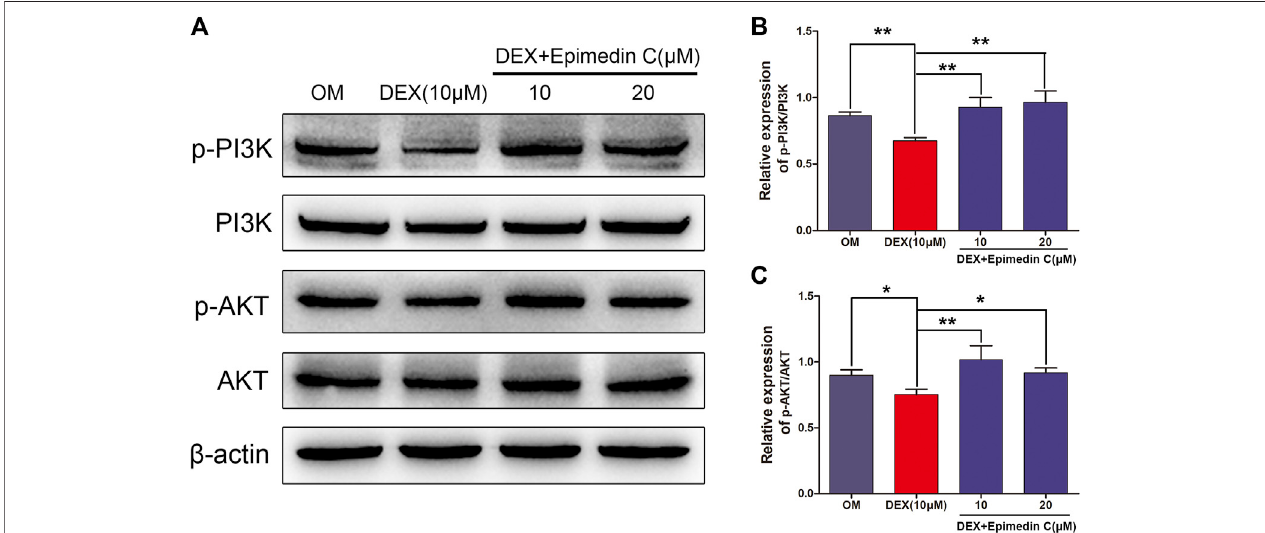
FIGURE 5 | Epimedin C activated AKT and PI3K phosphorylation in MC3T3-E1 cells treated using DEX. (A) Western blotting was employed to assess the proportions of phosphorylated PI3K and AKT. As an endogenous control, β -actin was employed. (B,C) : ImageJ was used to quantify the p-PI3K/PI3K and p-AKT/AKT ratios as depicted by the bar charts. DEX: dexamethasone, OM: osteogenic induction medium. * p < 0.05, ** p < 0.01.